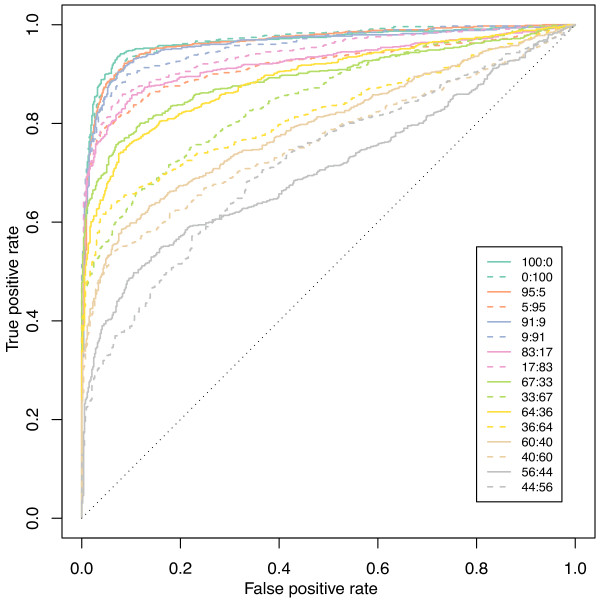
ROC plots for the mixture control data set.